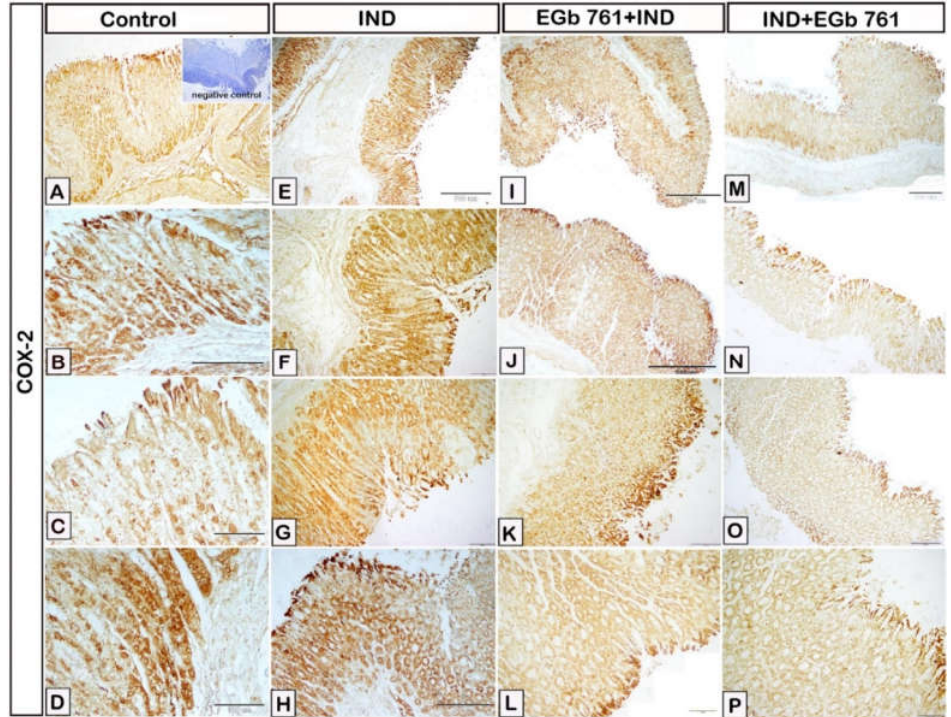
Figure 5. Photomicrograph immunohistochemistry of gastric mucosal expression of COX-2. ( A – D ): Control mice. ( E – H ): Indomethacin-induced ulcer (IND). (I-L): EGb 761 +IND (Prophylactic EGb 761). ( M – P ): IND+EGb 761 (Therapeutic EGb 761). Negative marker control is shown in the inset of Figure 5A. IND: Indomethacin; EGb 761: Standardized G. biloba extract; COX-2: Cyclooxygenase-2.